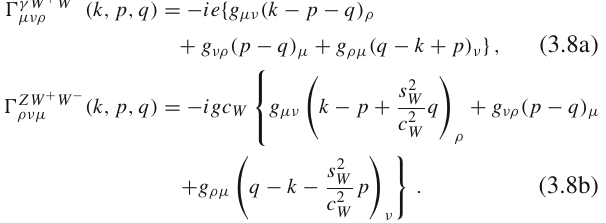
W − ρ ( q ) (all momenta incoming) triple-gauge vertices now have the following modified Feynman rules.